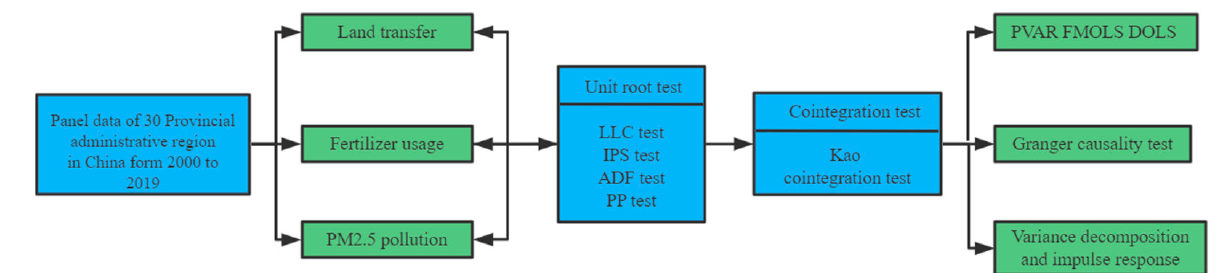
Figure 2. Study content and methodology framework.